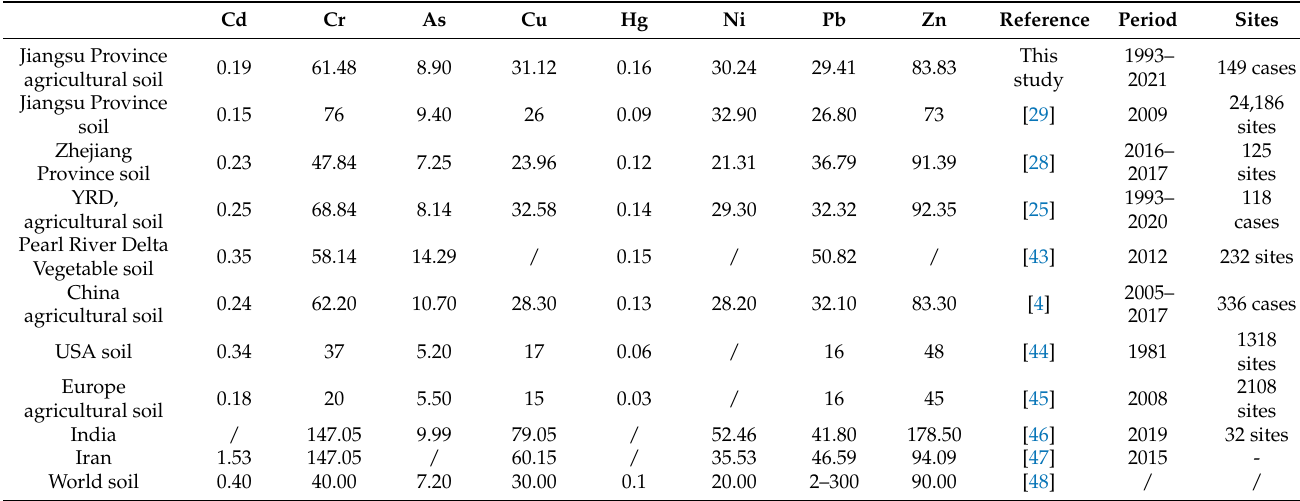
Table 3. The comparison between this study and other